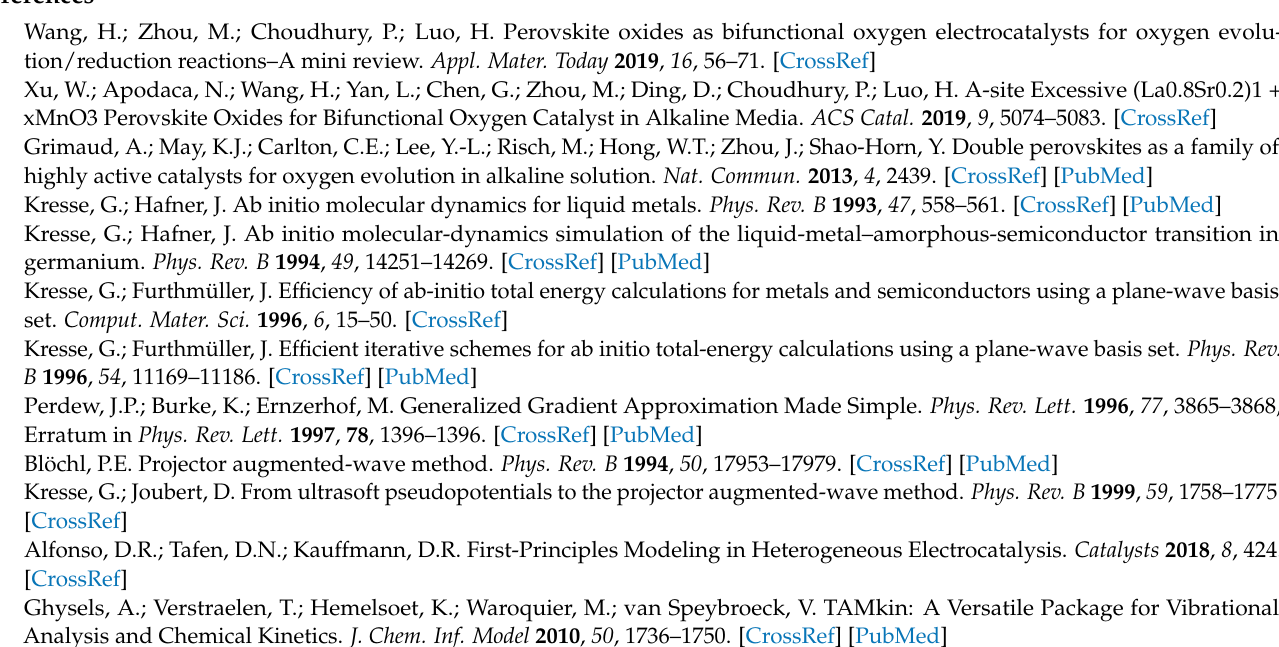
LSMO and ALSMO. Figure S2: Free energy diagram of a four-step OER on LSM. OER occurs from left to right on the profile, Figure S3: Free energy diagram of a four-step OER on ALSM. OER occurs from left to right on the profile, Figure S4: Free energy diagram of a four-step OER on LSMO. OER occurs from left to right on the profile, Figure S5: Free energy diagram of a four-step OER on ALSMO. OER occurs from left to right on the profile, Figure S6: Free energy diagram of a four-step ORR on LSM. ORR occurs from left to right on the profile, Figure S7: Free energy diagram of a four-step ORR on ALSM. ORR occurs from left to right on the profile, Figure S8: Free energy diagram of a four-step ORR on LSMO. ORR occurs from left to right on the profile, Figure S9: Free energy diagram of a four-step ORR on ALSMO. ORR occurs from left to right on the profile, Figure S10: Plots of surface Mn d-DOS and median energy of LSM, ALSM, LSMO, and ALSMO structures, Figure S11: Ground state formation energy for *OH intermediates plotted as it varies with the B and A site. Table S1: The Mn–O bond distances and oxidation state of Mn atom of optimized LSM, ALSM, LSMO and ALSMO